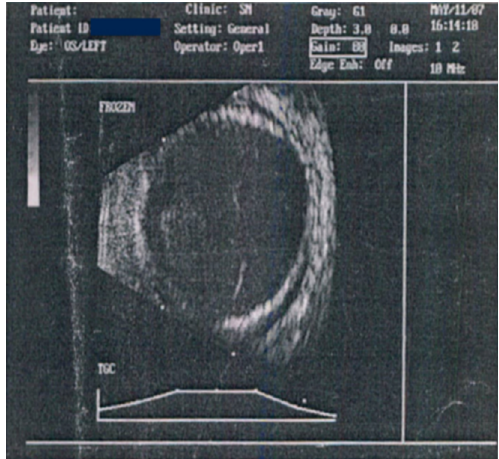
Figure 1: USG B-scan of the left eye showing shallow 360 degree of serous choroidal detachment.